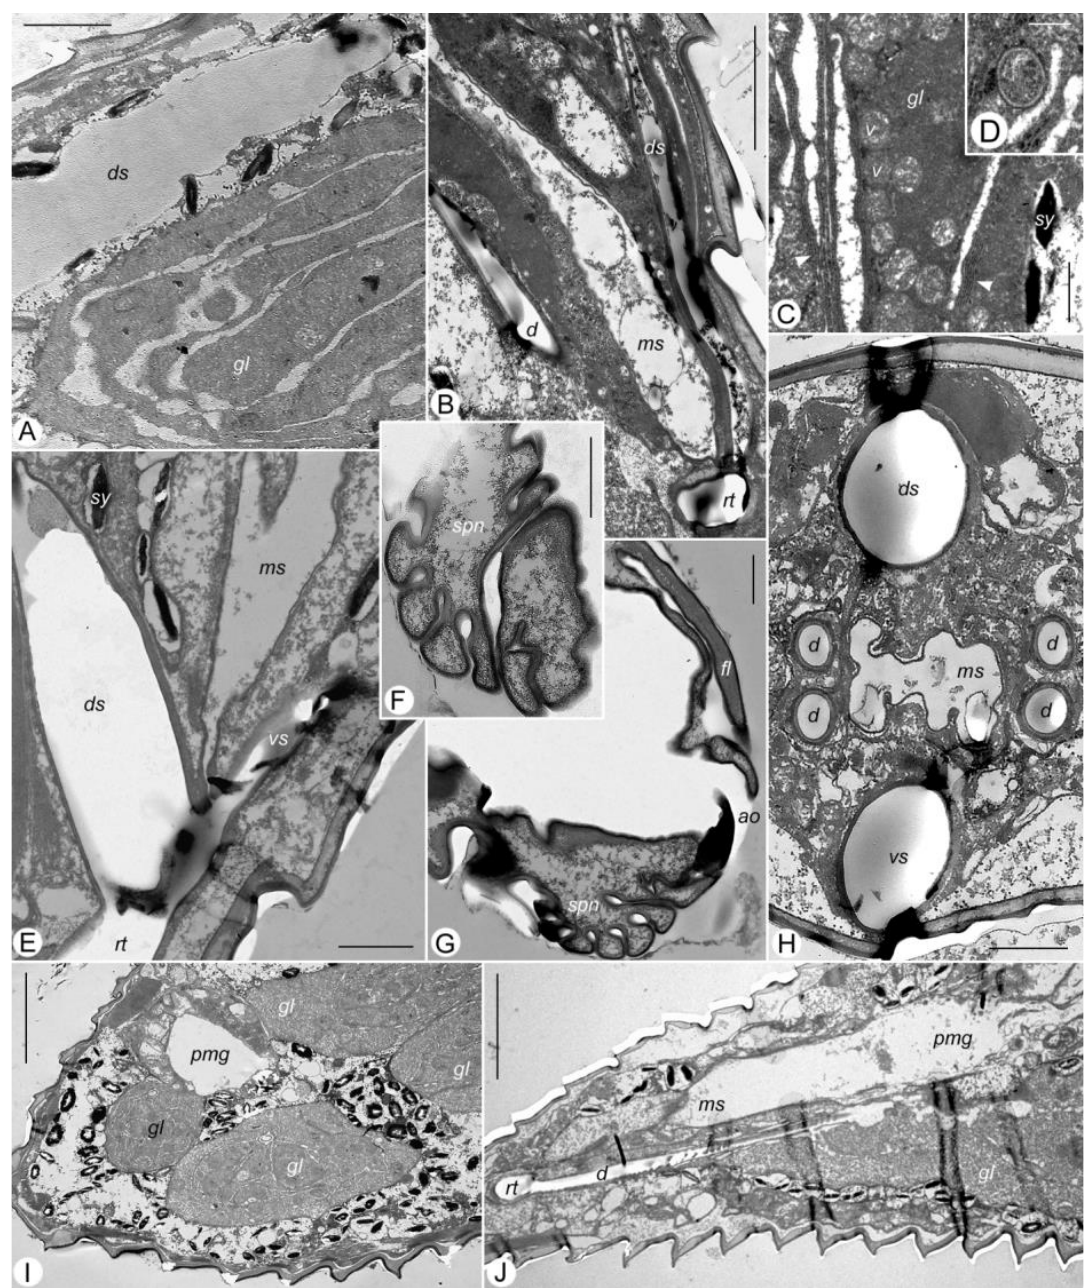
Figure 12. Transmission electron micrographs of caudal body region of web-spinning females of Aberoptus schotiae n. sp. ( A )—dorsal sac and anal gland, ( B )—oblique section at the level where common gland duct and sacs join rectal tube, ( C , D )—vesicles ( C ) and mitochondria ( D ) in the cell of anal gland (arrowheads in Figure 12C indicate endoplasmic reticulum), ( E )—junction area of rectal tube and three sacs, ( F )—cross section of spinneret, ( G )—spinneret, anal opening, and cuticular flap, ( H )—frontal section at the level of the third telosomal annulus, ( I )—four anal glands and pu- tative posterior midgut displaced towards dorsal cuticle, ( J )—longitudinal section through region of transition between medial sac and putative posterior midgut. Notations: ao —anal opening, d —duct of anal gland, ds —dorsal sac, fl —cuticular flap, gl —anal gland, ms —medial sac, pmg —putative posterior midgut, rt —rectal tube, spn —spinneret, sy —symbiotic bacteria, v— vesicles, vs —ventral sac. Scale bars: ( A , B ) = 2 µ m; ( C , E , H ) = 1 µ m; ( D ) = 0.25 µ m; ( F , G ) = 0.5 µ m; ( I , J )—5 µ